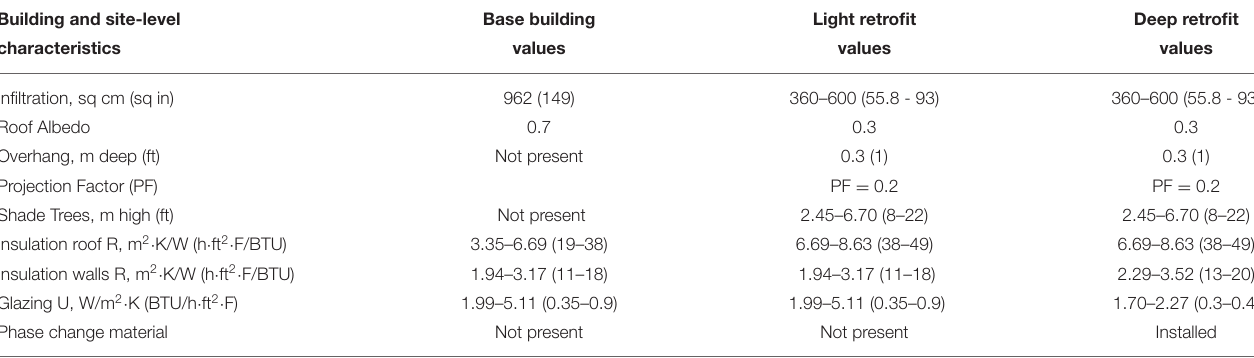
TABLE 2 | Characteristics of the model buildings and the improved